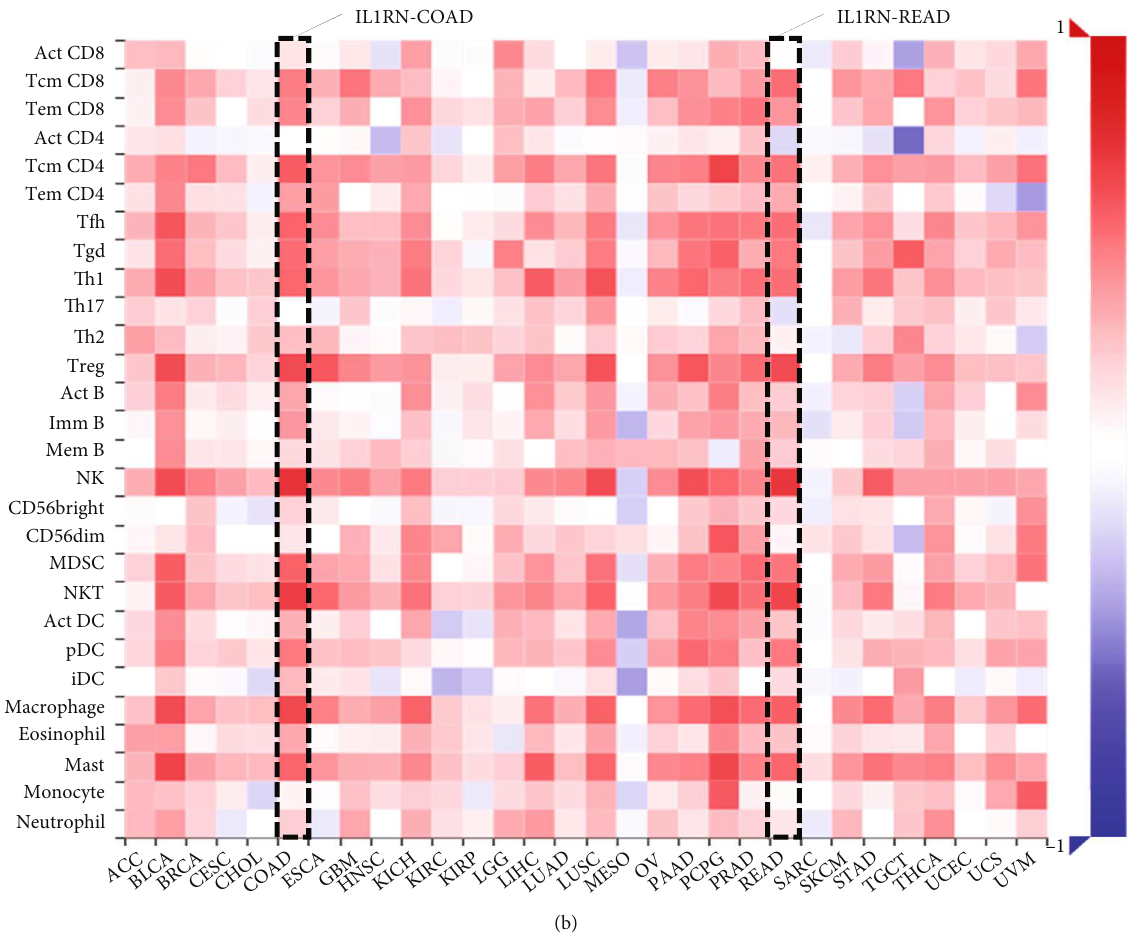
Figure 6: Correlation of IL1RN and PRRX1 expression with immune in fi ltration in CRC. (a) and (b) Correlation between the expression of IL1RN and PRRX1 and the abundance of TILs in CRC available at TISIDB